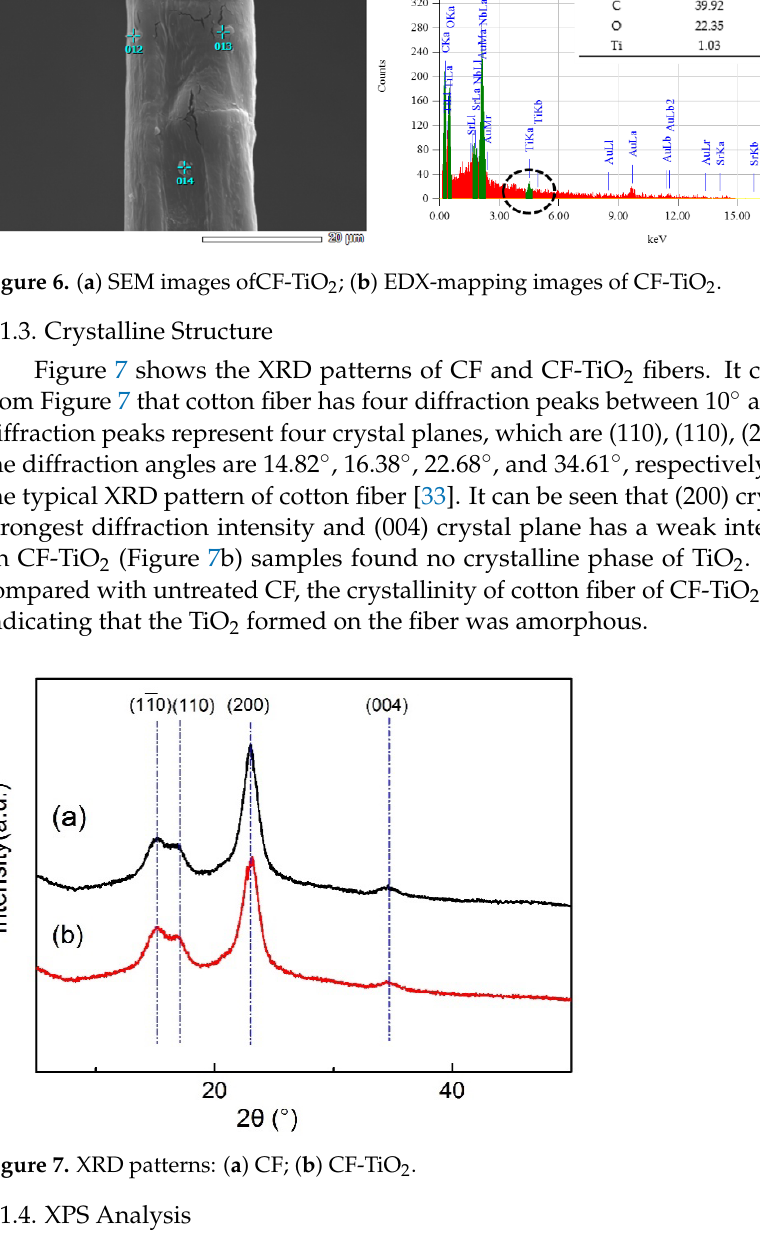
6 of 13 Figure 5. SEM images: ( a ) CF; ( b ) CF-TiO 2 .